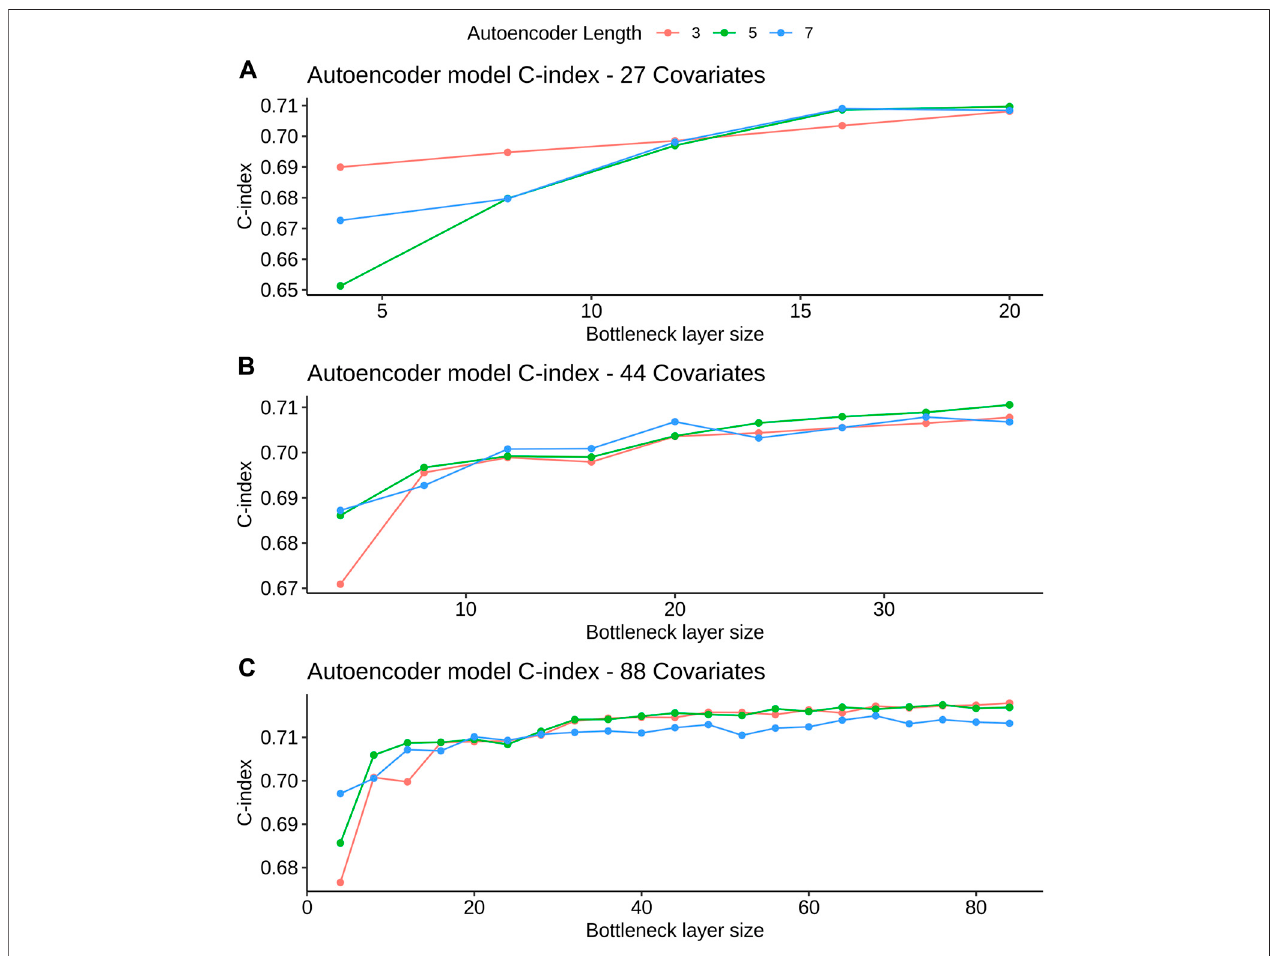
FIGURE3| AEmodelC-indexvaluesfordifferentbottlenecklayersizesandtotallayersizes.AllC-indexvaluesarereferenttothevalidationsetderivedfromFHtrain (see Datasets section for more details). Figures A, B and C refer to the 27, 44 and 88 covariate models, respectively.